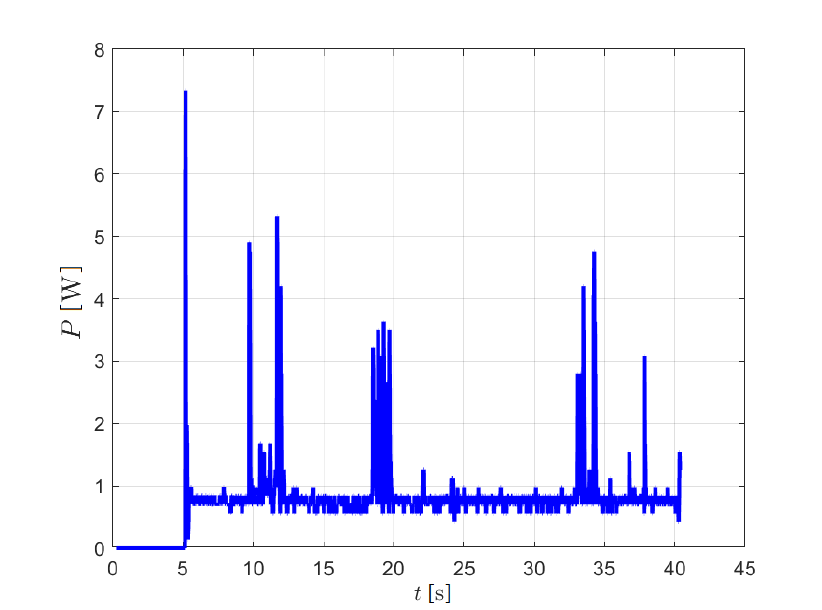
Figure 40. Power P during Map 2 run for the RRT star algorithm of the